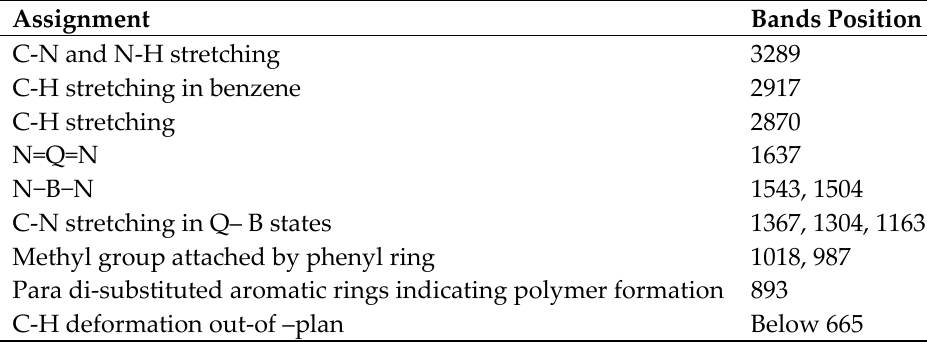
Figure 2. Infrared spectrum of polyester textile coated with polyaniline. Table 1. The frequencies characteristic in infrared for polyester coated with